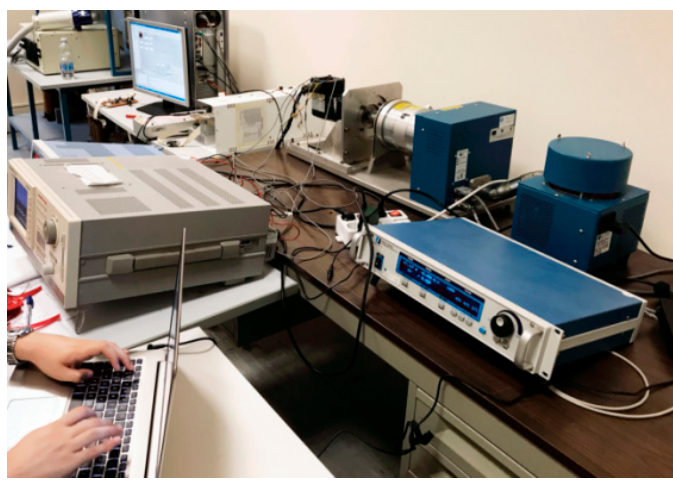
Figure 4. A photograph of the test bench during the power losses measurements.